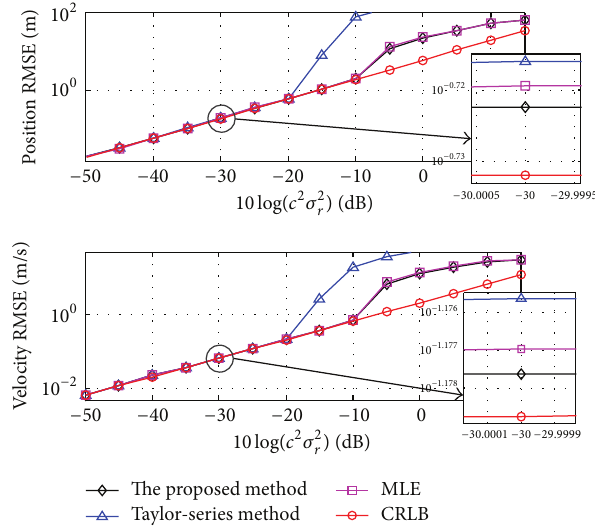
Figure 5: Comparison of the estimation bias of the proposed method with the original MLE against the Gaussian TDOA and FDOA noise for near-field source. The result is shown in log scale as the noise power increase.